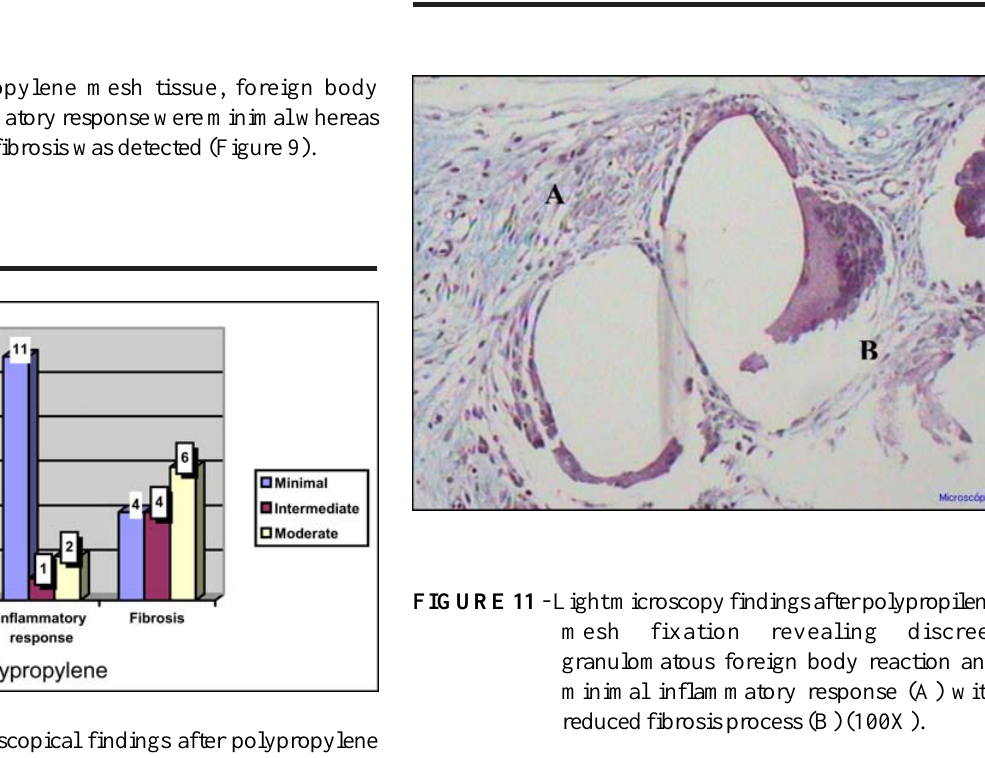
FIGURE 9 - Microscopical findings after polypropylene mesh fixation.